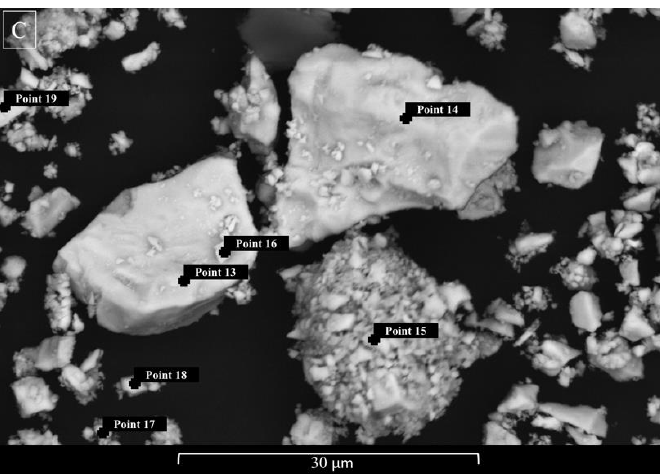
Figure 10. SEM images of the initial FeAsS particles ( A ) and particles after hydrothermal treatment ( B ) in cross-sectional view; bulk particles ( C ) after hydrothermal treatment.